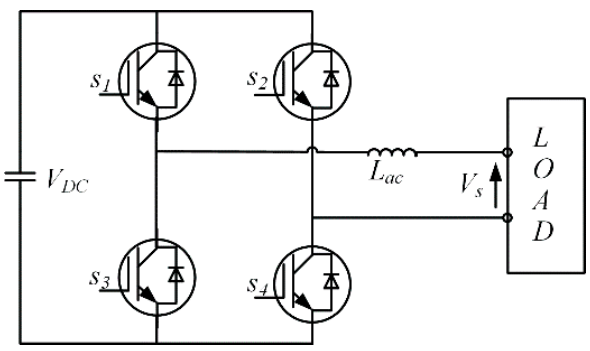
Figure 10. Single-phase H-bridge DC to AC inverter test circuit. The losses are evaluated with three different DC bus voltages.